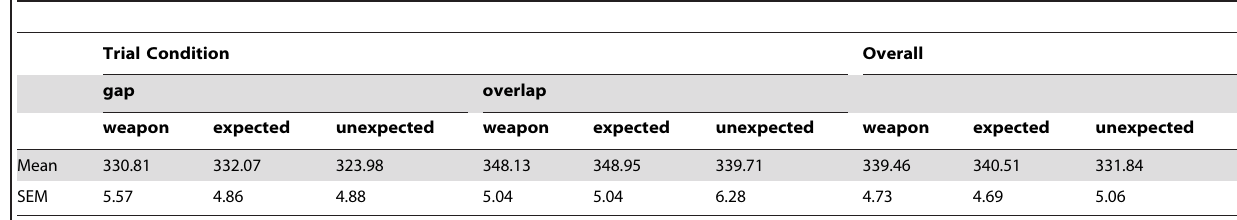
Table 1. Group means and standard errors (SEM) of the saccadic reaction times (SRT) by object condition (weapon, expected and control) and trial type (gap and overlap) in Experiment 2, which employed the prosaccade gap-overlap